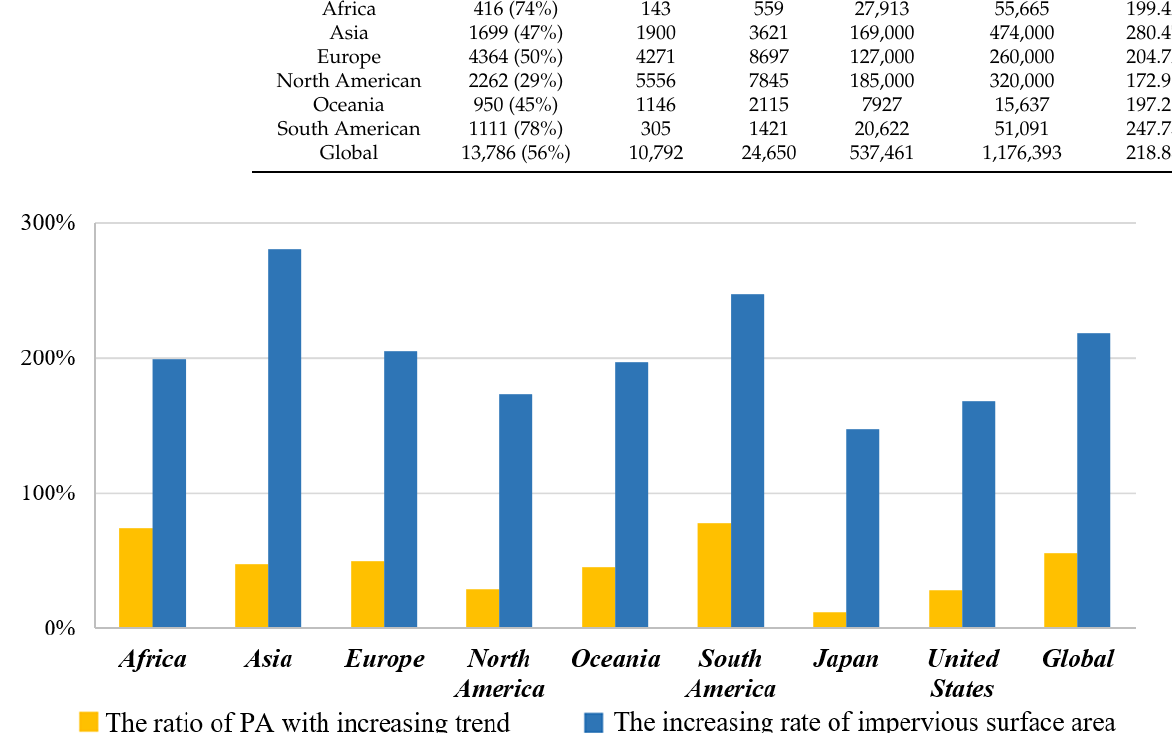
Figure 8. The relationship between light pollution (i.e., the ratio of polluted PA with an increasing trend) and urbanization (i.e., the increasing rate of impervious surface areas).